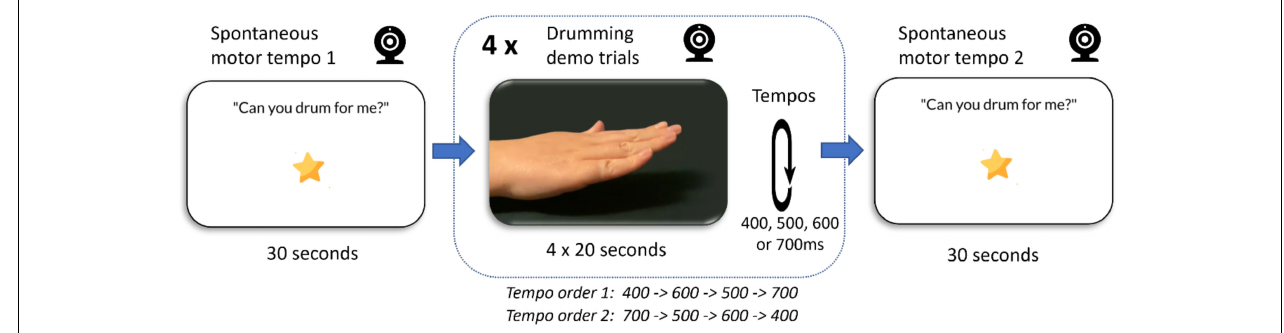
FIGURE 1 | Schematic of the data collection trials. Using the Lookit platform, children saw six short videos and their responses were video recorded. First and last trial lasted 20 s and captured infants own spontaneous drumming. Trials 2–5 each demonstrated drumming at four different tempos (an inter-stimulus intervals of 400, 500, 600, or 700 ms per